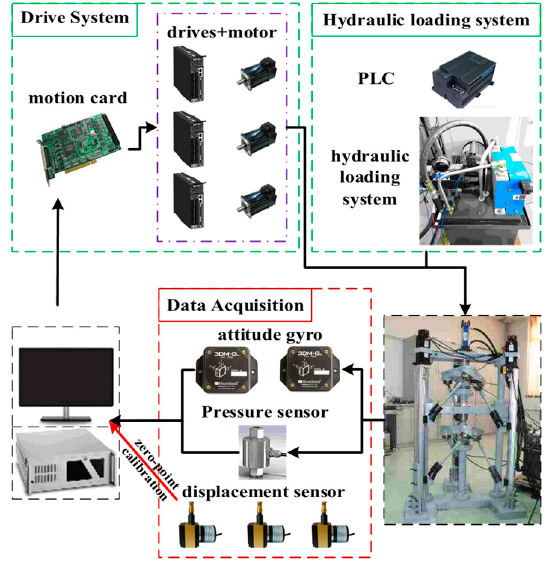
Figure 10. Control and data acquisition system of the parallel manipulator.